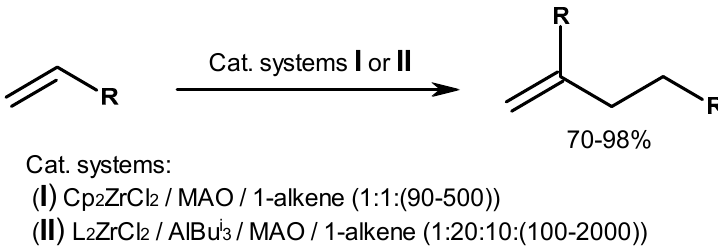
Table 1. Catalytic activity and chemoselectivity of systems A and B in the reaction with 1-hexene. Catalytic Entry